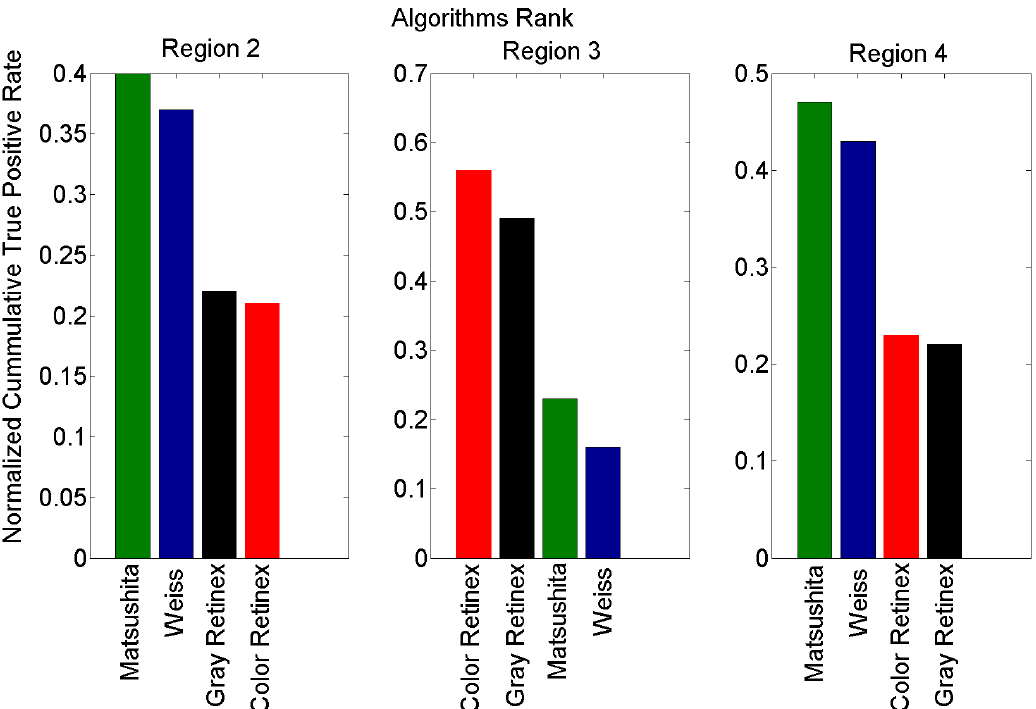
Figure 7. Quantitative comparison of all the algorithms. The regions R correspond to the interval of analysis defined by the vertical lines of Figure